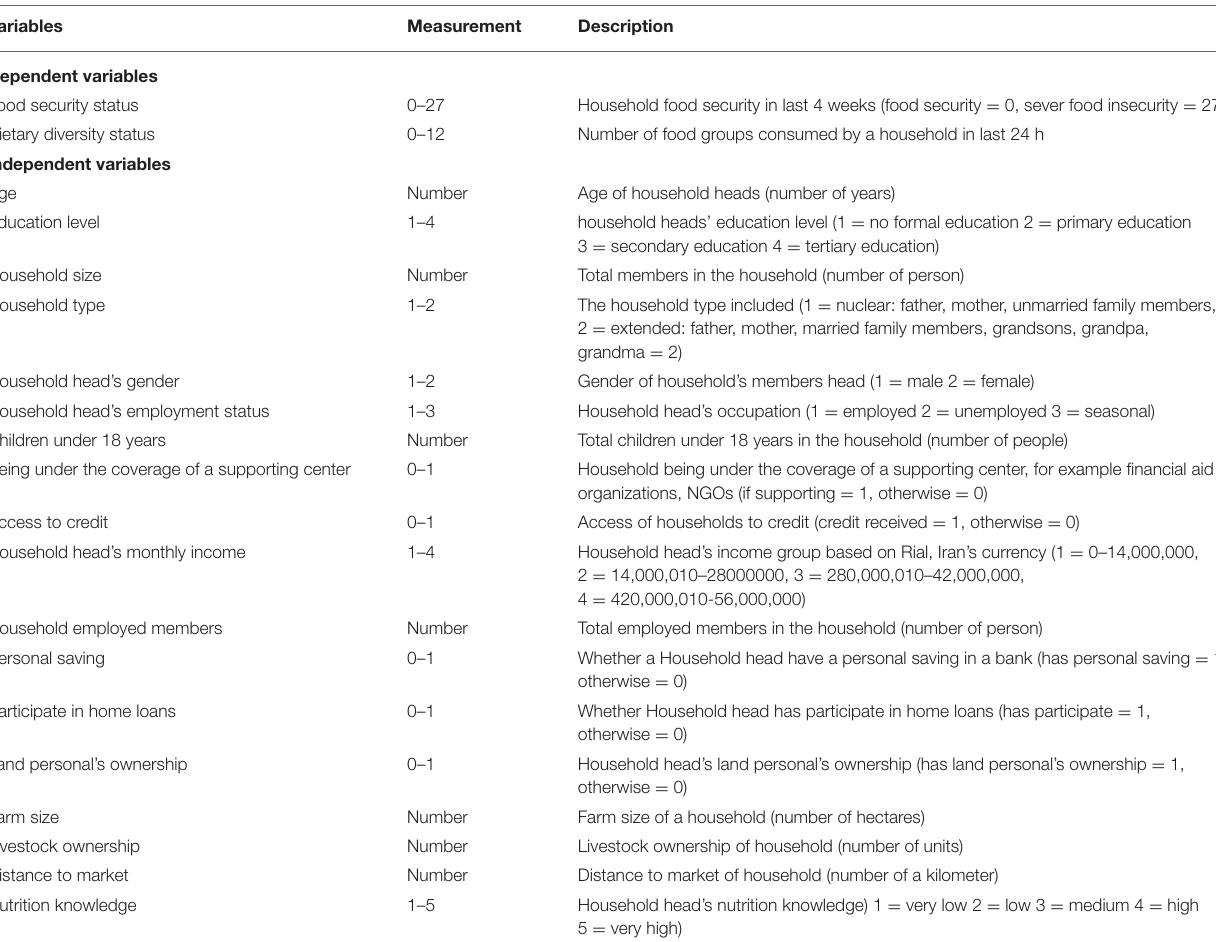
TABLE 2 | Description of the variables studied in the